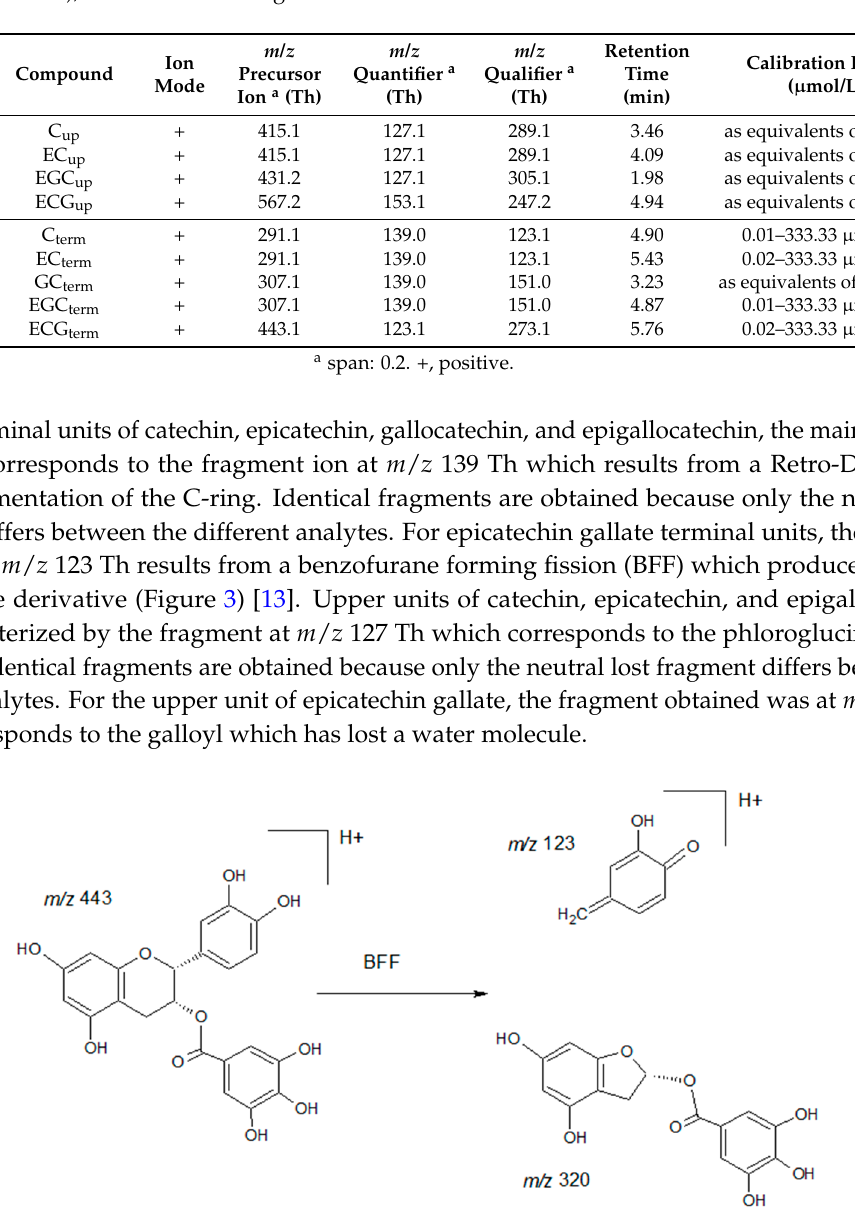
Table 1. List of quantified compounds, MRM parameters (ion mode, precursor and product ions m / z , retention times), and calibration ranges.